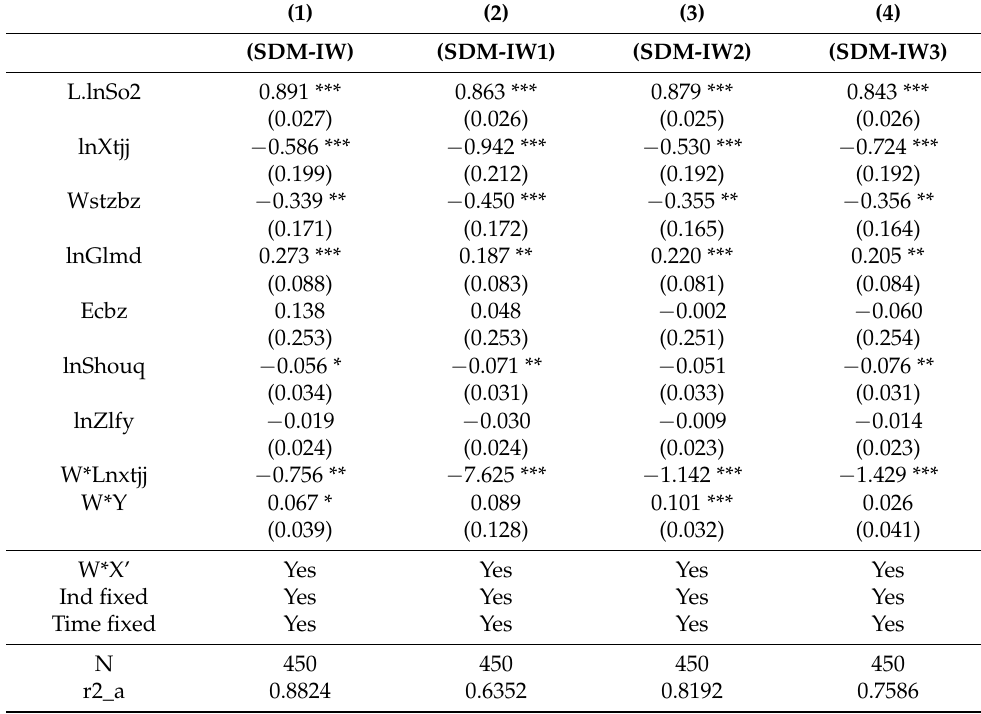
Table 4. The empirical results of the baseline